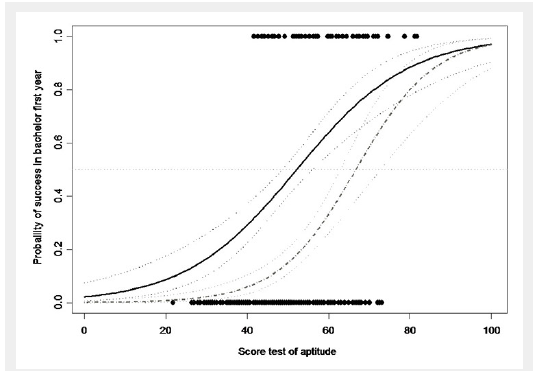
Probability of success during bachelor year 1 as a function of the score at the aptitude test (n = 288). The continuous line is the probability of success after one or two attempts and the dashed line is the probability of success without repeating year 1. The fitted lines obtained with logistic regression models are drawn with 95% confidence